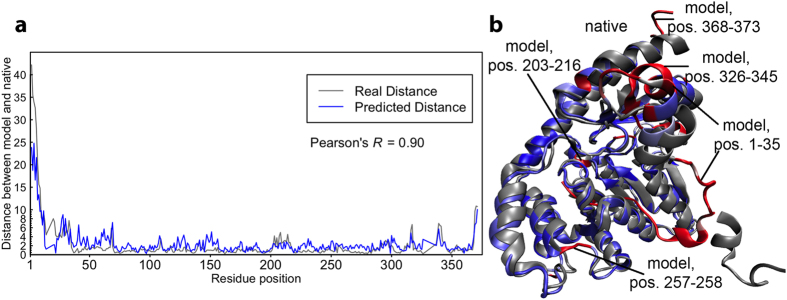
(a) an example illustrating the predicted deviations generated by Wang_deep_2 and the observed deviations from superimposing the experimental structure on the predicted model. The model in this example is “raghavagps-tsppred_TS3” for target T0819 in CASP11. (b) The visualization of the superimposition with the model in the color blue or red whereas red regions are the segments that have relatively larger real distances (>~3.5 Å) and blue for regions with relatively smaller real distances.